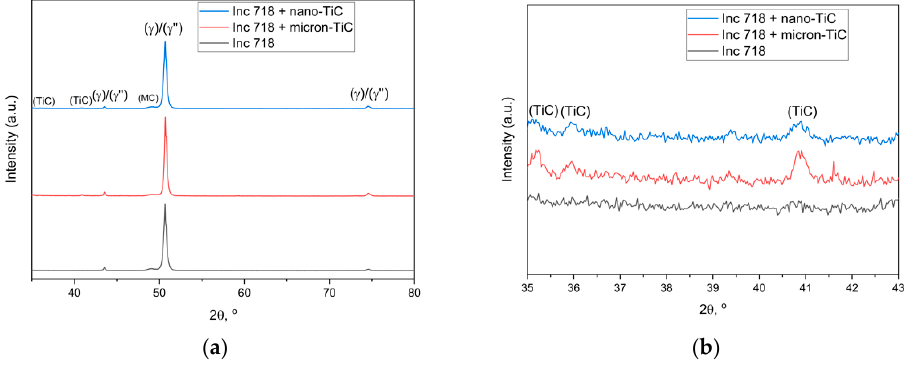
Figure 5. X-ray diffraction patterns of the processed (HIP + H.T.) samples ( a ); enlarged part of the graph ( b ).